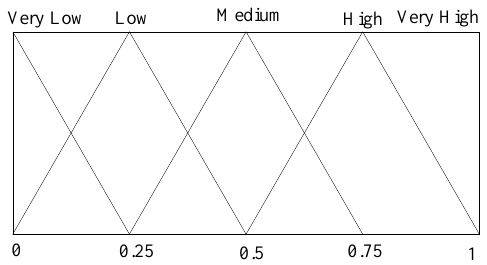
Figure 6. The membership of the residual energy.